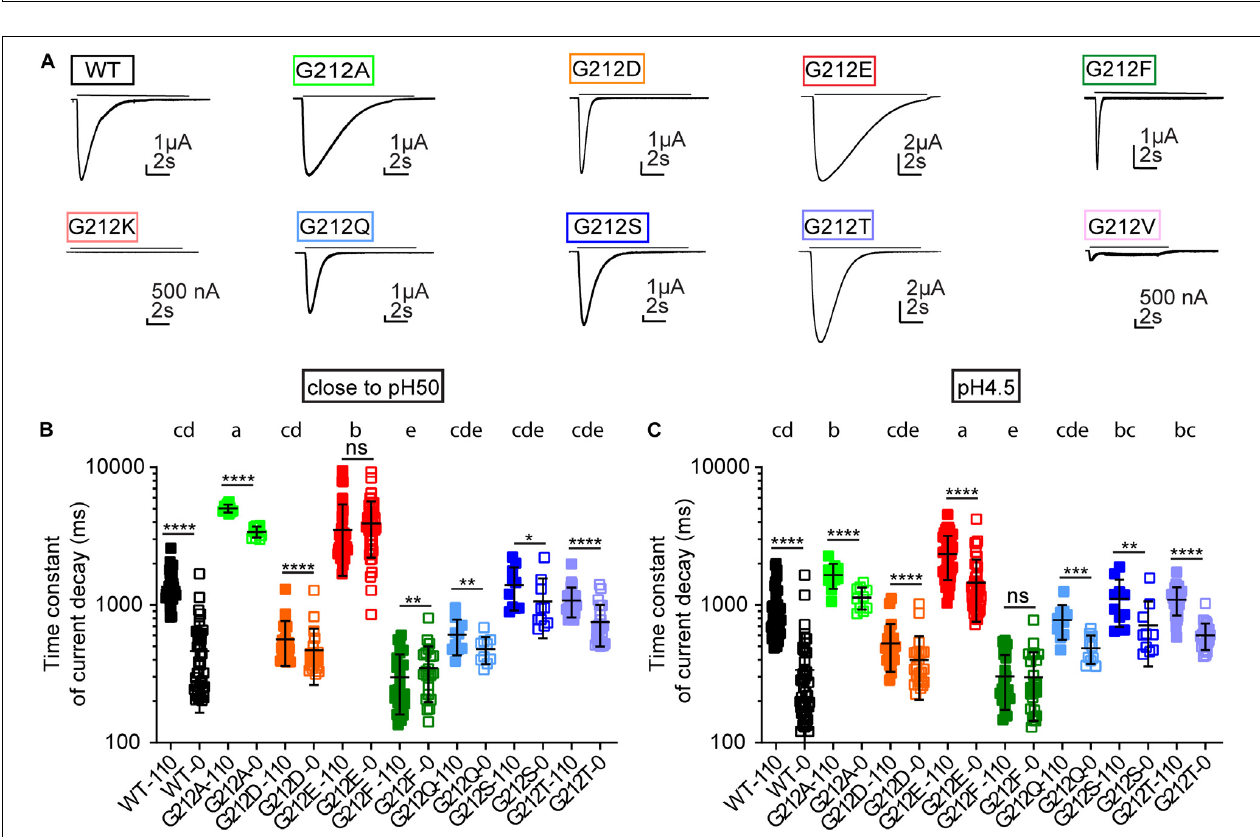
FIGURE 6 | Kinetics of current decay. (A) Representative current traces of the WT and the Gly212 mutants. Conditioning pH7.4 (pH7.8 for G212F) was applied for 50 s followed by a 10 s step stimulation at pH6 (indicated by the horizontal line). (B) Time constant of current decay at 0 and 110 mM Cl - . In the 0 mM Cl - condition, Cl - was replaced by SCN - . ASICs were stimulated by a pH that was close to their pH 50 . Mutants that do not share the same letters are significantly different in the condition of 110 mM Cl - ( n = 10–43, p < 0.05). (C) Time constant of current decay at pH4.5, at 0 and 110 mM Cl - . Mutants that do not share the same letters are significantly different in the condition of 110 mM Cl - ( n = 10–43, p < 0.05). Measurements at 0 and 110 mM Cl - were performed on the same oocyte. Ordinary One-Way ANOVA followed by Tukey’s HSD test for multiple comparisons was used for statistics, paired t -tests were used to compare 0 and 110 mM Cl - for each mutant; * p < 0.05; ** p < 0.01; *** p < 0.001; **** p < 0.0001; ns,